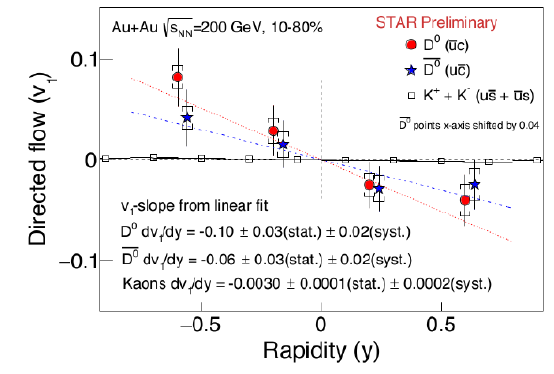
Figure 2. Directed flow as a function of rapidity for D 0 mesons in 10–80% centrality Au + Au collisions √ s NN = 200 GeV compared with directed flow of K + + K − . Data points for ¯ D 0 are slightly shifted at for visibility